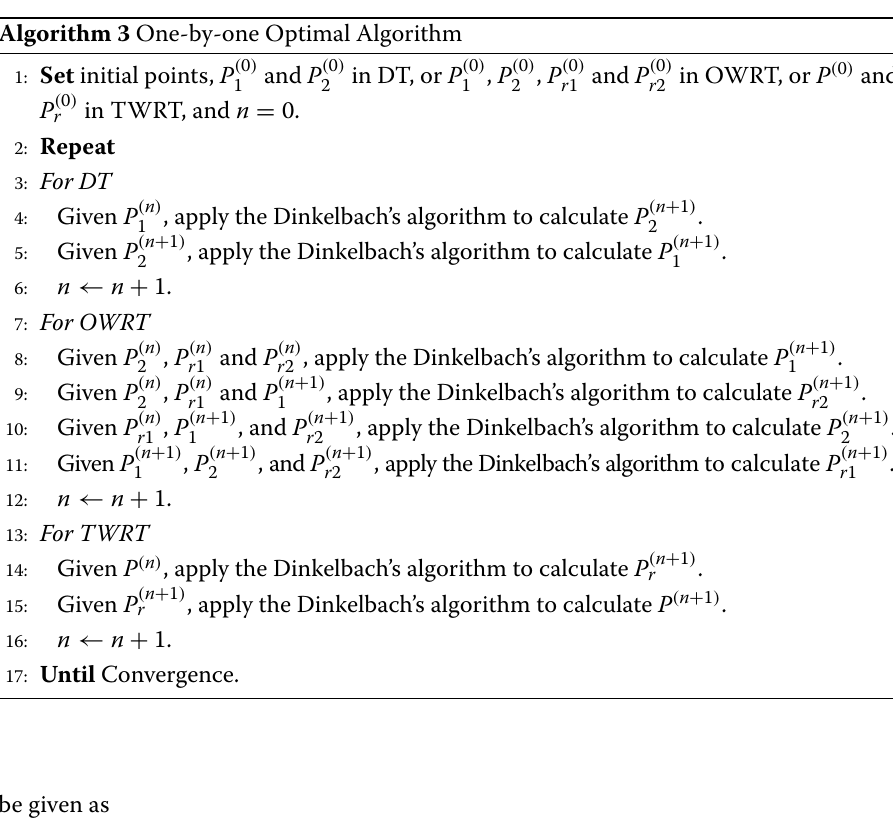
Algorithm 3 One-by-one Optimal